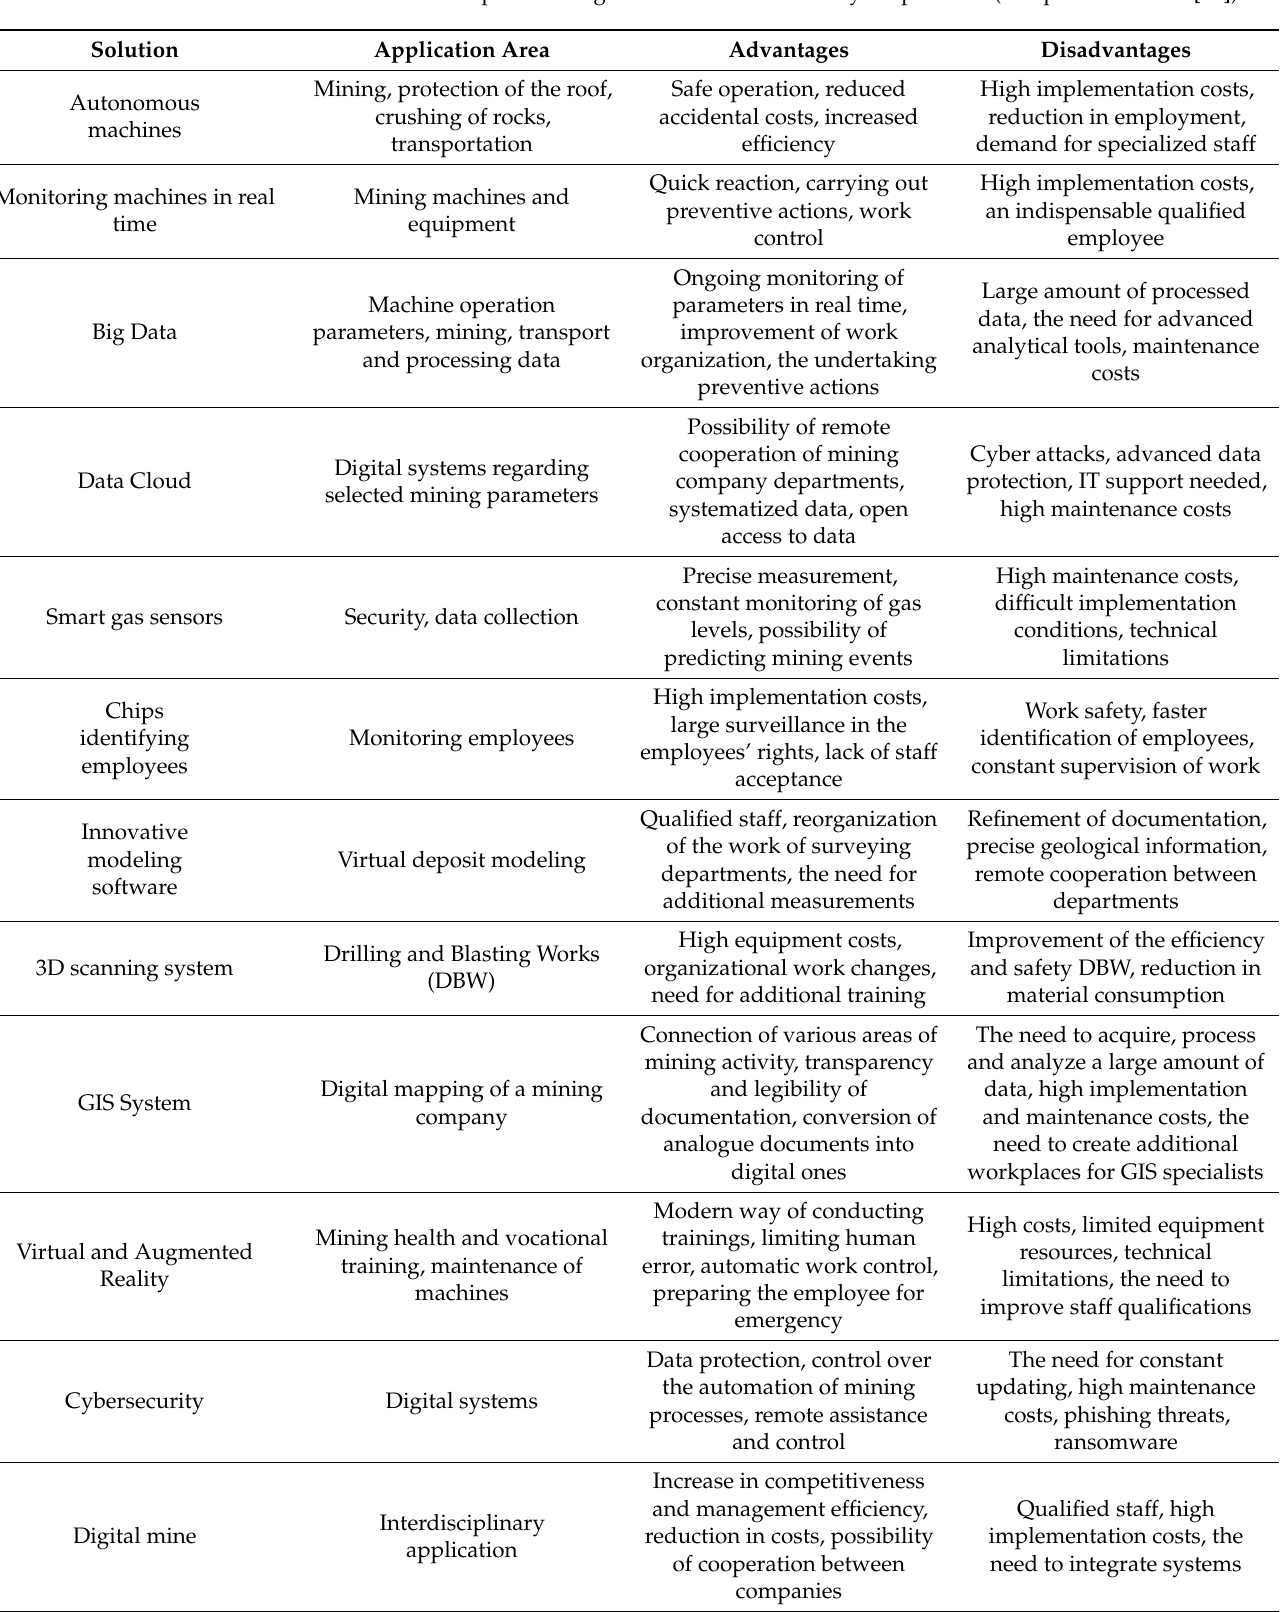
Table 1. The concept of Mining 4.0 based on the Industry 4.0 platform (Adapted from Ref.